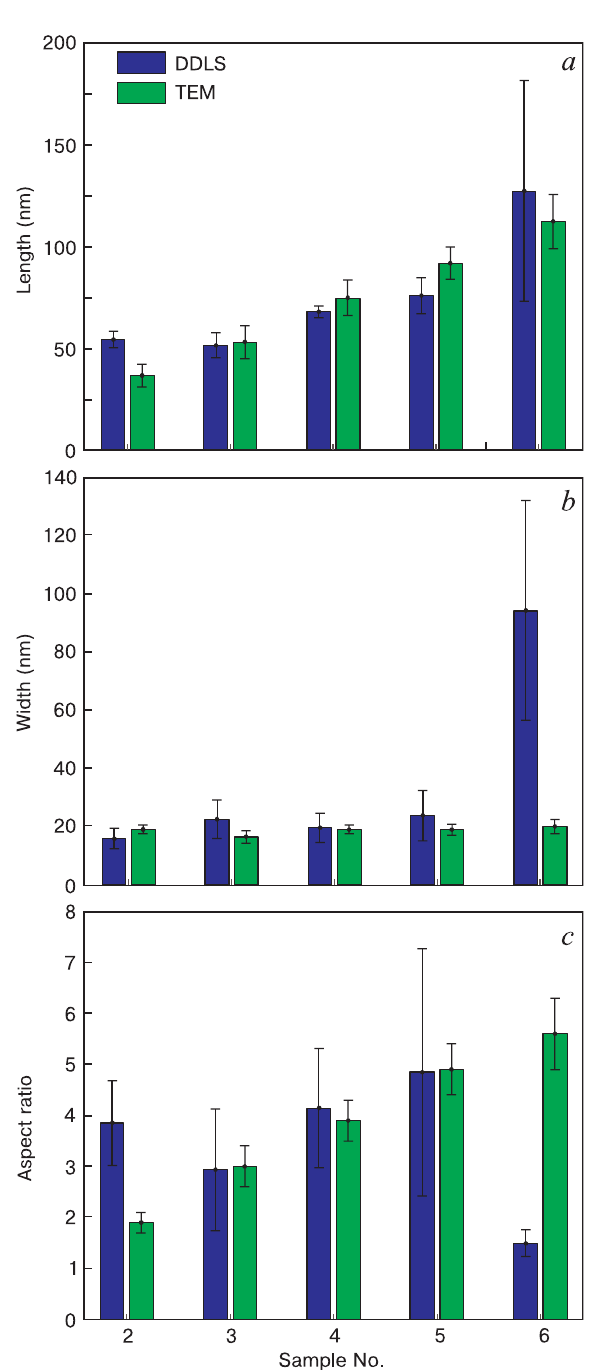
Fig. 3. The values of length ( a ), width ( b ) and aspect ratio ( c ) measured by DDLS and TEM